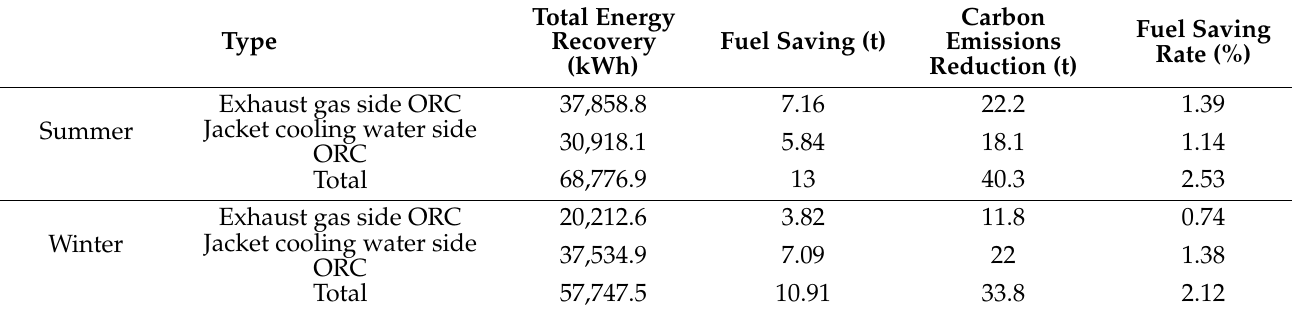
Table 11. Energy saving and fuel saving rate of the ship when adopting high-sulfur fuel